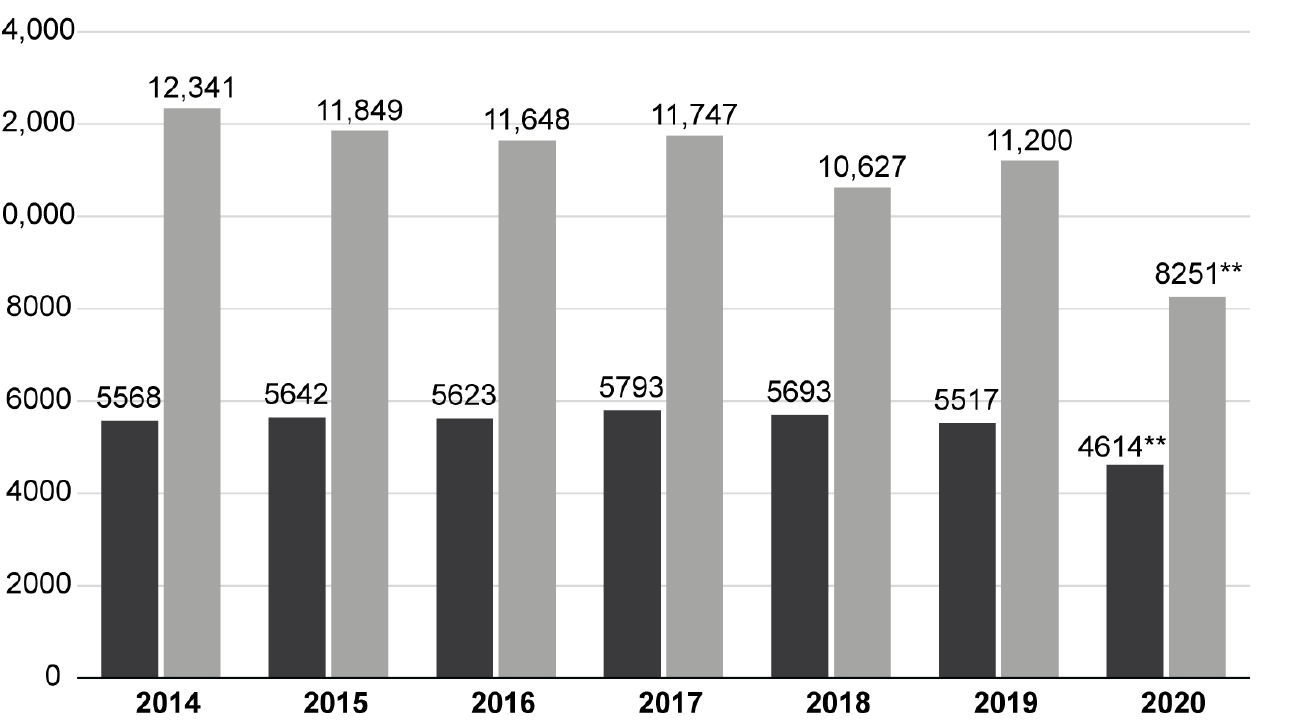
Figure 1. Comparison of the annual TBI patient volume between the pre-COVID-19 period and 2020. ** p < 0.001.